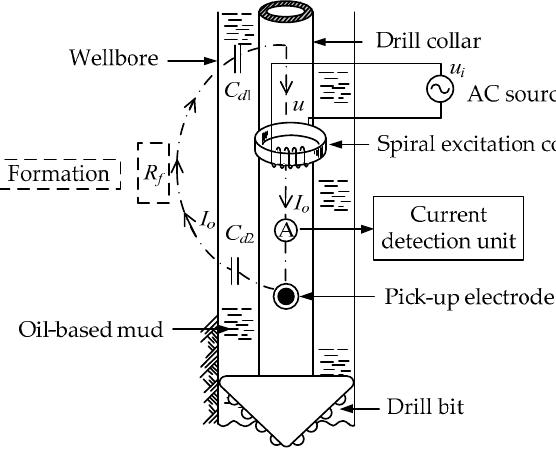
Figure 6. Basic structure of the logging instrument.